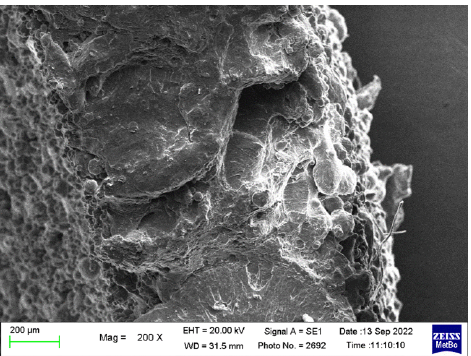
Figure 6. Defect extending through the entire thickness of a 1.2 mm walled specimen.